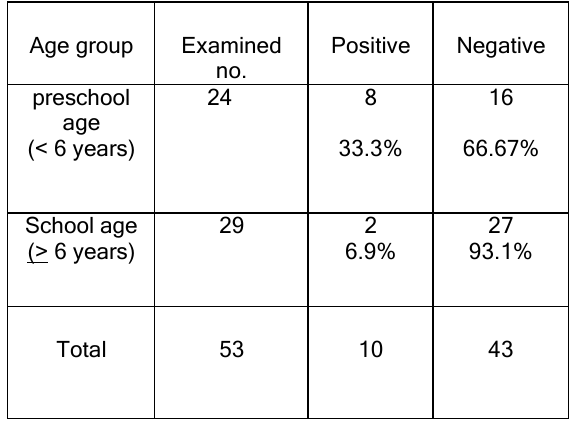
Blastocystis spp. cyst stained by Lugol's iodine stain (large central vacuole stained yellow-brown color and the peripheral nuclei stained dark brown-black color) Blastocystis spp. cyst stained by Iron hematoxylin stain (large central vacuole stained gray color and the peripheral nuclei stained black color) Table 2: The relationship between age group of leukemic children and Blastocystisinfection